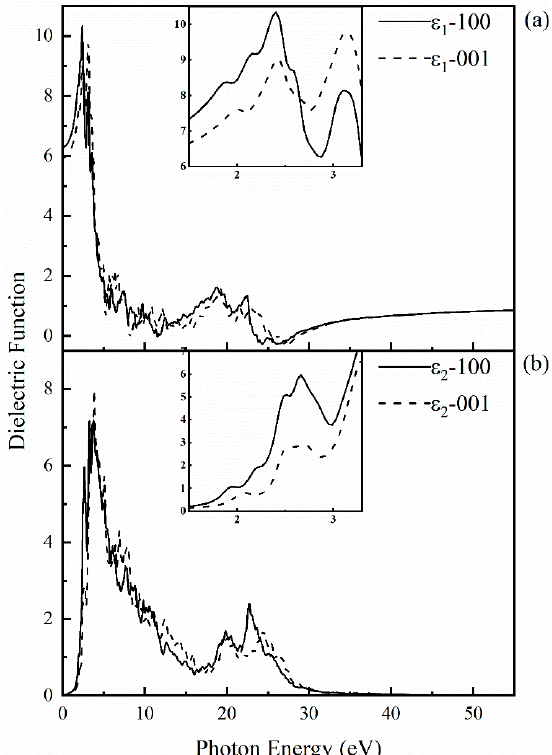
Figure 5. Calculated complex dielectric function for SrCu 2 O 2 : ( a ) the real part along the (100) and (001) directions; ( b ) the imaginary part along the (100) and (001) directions. The insets present the obtained data for the real and imaginary parts of the dielectric function in the visible light region (1.5–3.3 eV), respectively.